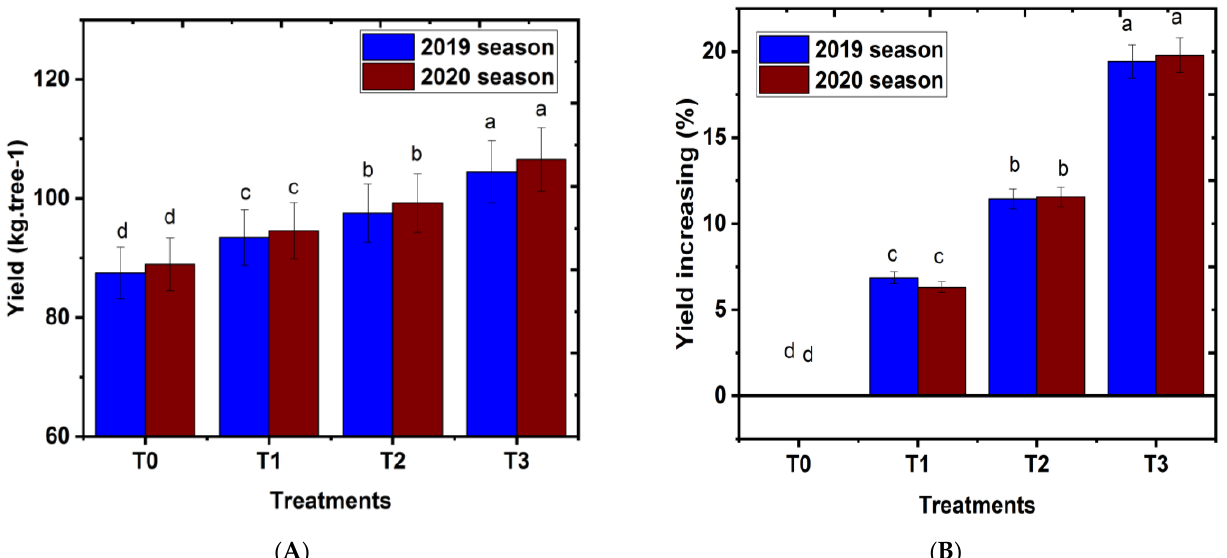
Figure 4. Effect of magnetic iron application on ( A ) yield kg.tree −1 and ( B ) yield increasing (%) of ‘Chinese’ mandarin trees during 2019 and 2020 seasons. T0: 0 g magnetic iron.tree −1 , T1: 250 g magnetic iron.tree −1 , T2: 500 g magnetic iron.tree −1 , and T3: 750 magnetic iron.tree −1 . Bars indicate mean values ± SE ( n = 9). Different letters above columns indicate significant differences among magnetic iron treatments at p = 0.05 according to Bartlett’s test.